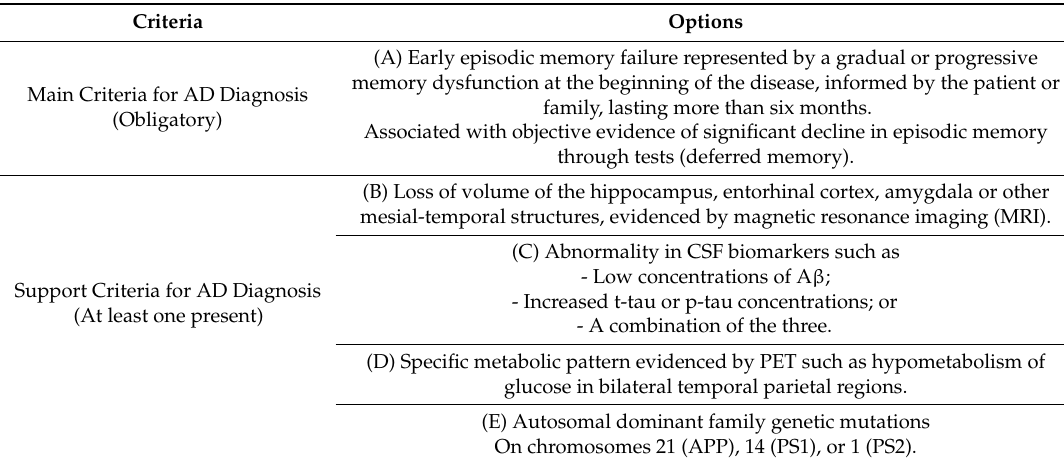
Table 1. Main proposed criteria for Alzheimer’s disease (AD) diagnosis by Dubois et al. (2007) [8].